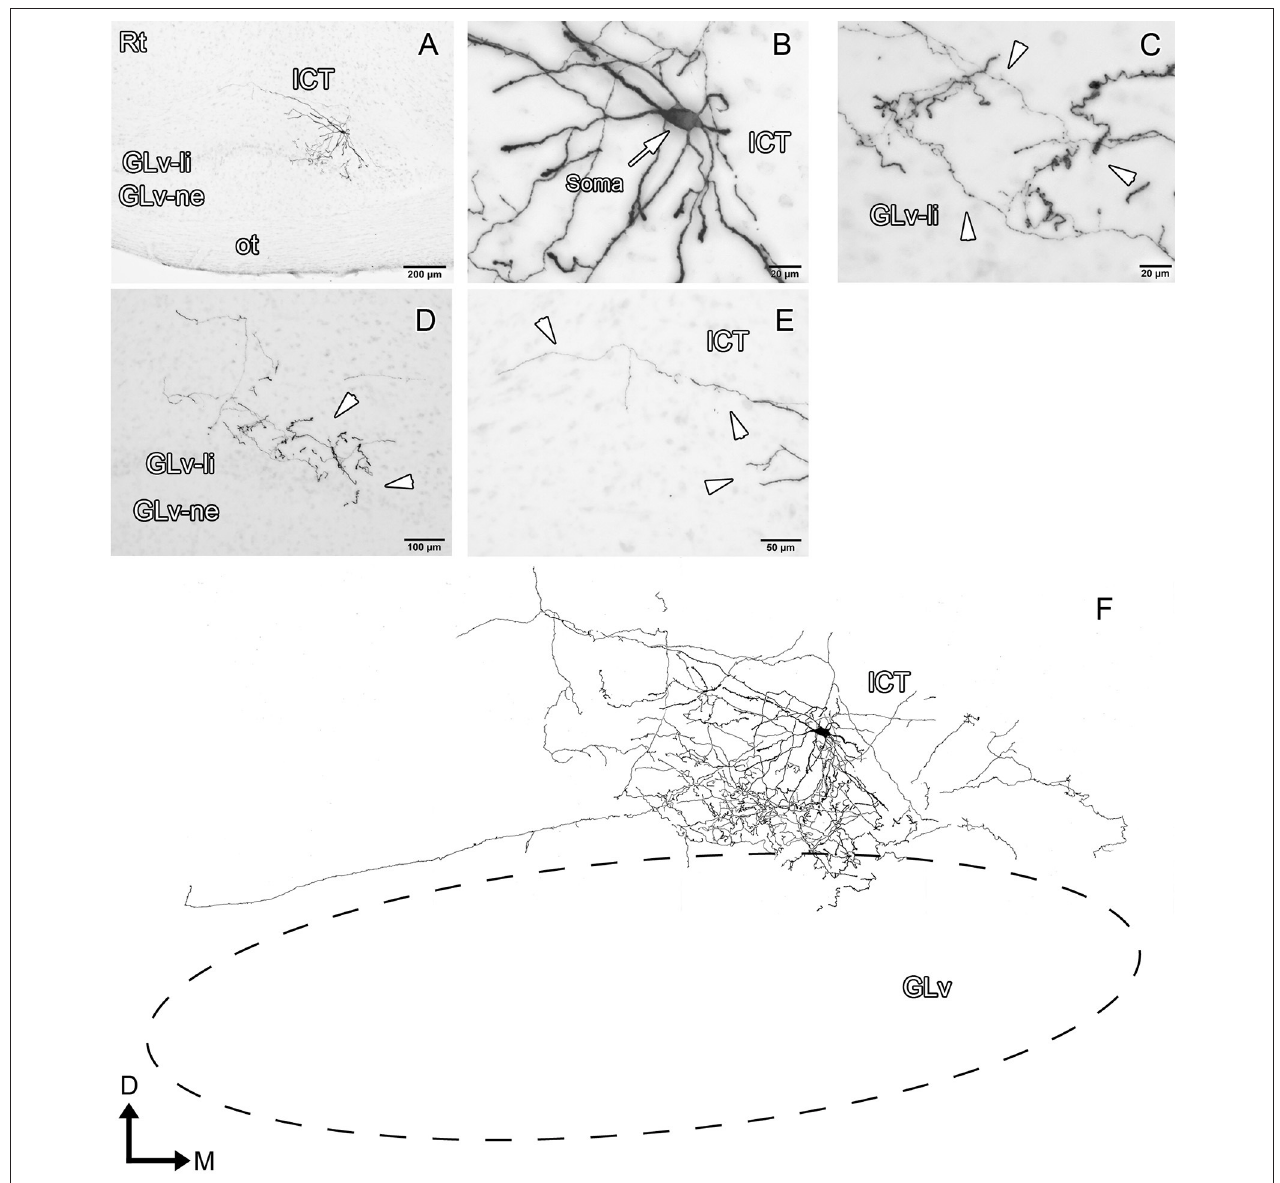
FIGURE 8 | Intracellular filling of an ICT cell (case1). (A–E) Photomicrographs showing the neuronal extension, soma location, and neural processes (white arrowheads). (F) Reconstruction of the biocytin-filled neuron. Note that the dendritic processes become denser in the GLv-li region. D, dorsal; M, medial. Orientation in (F) applies to (A–E)